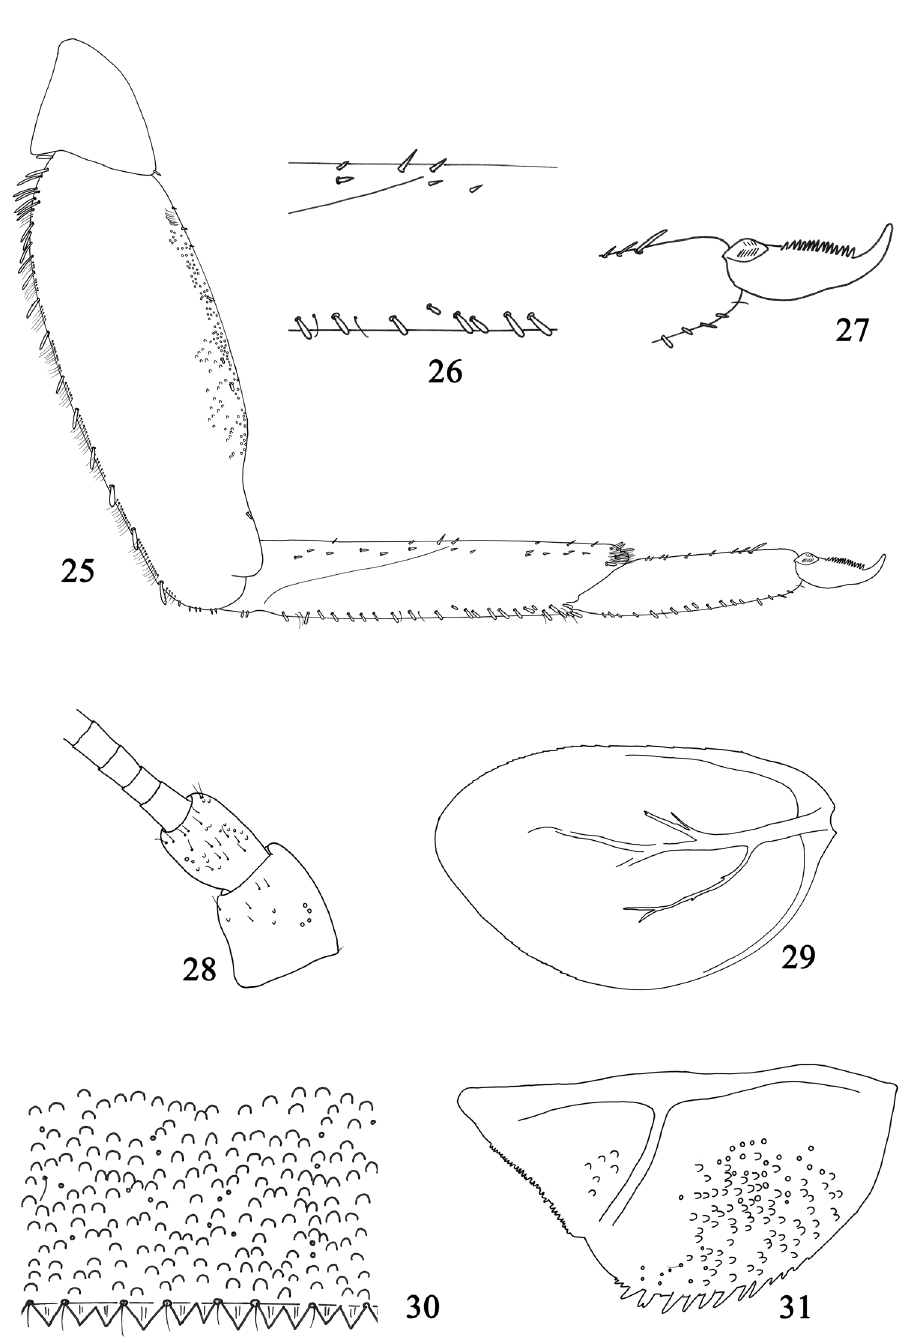
Figures 25–31. Larval structures of Labiobaetis alahmadii sp. n.: 25 foreleg 26 detail of ventral margin of foretibia 27 tarsal claw 28 base of antenna 29 fourth gill 30 posterior margin of fourth abdominal tergite 31